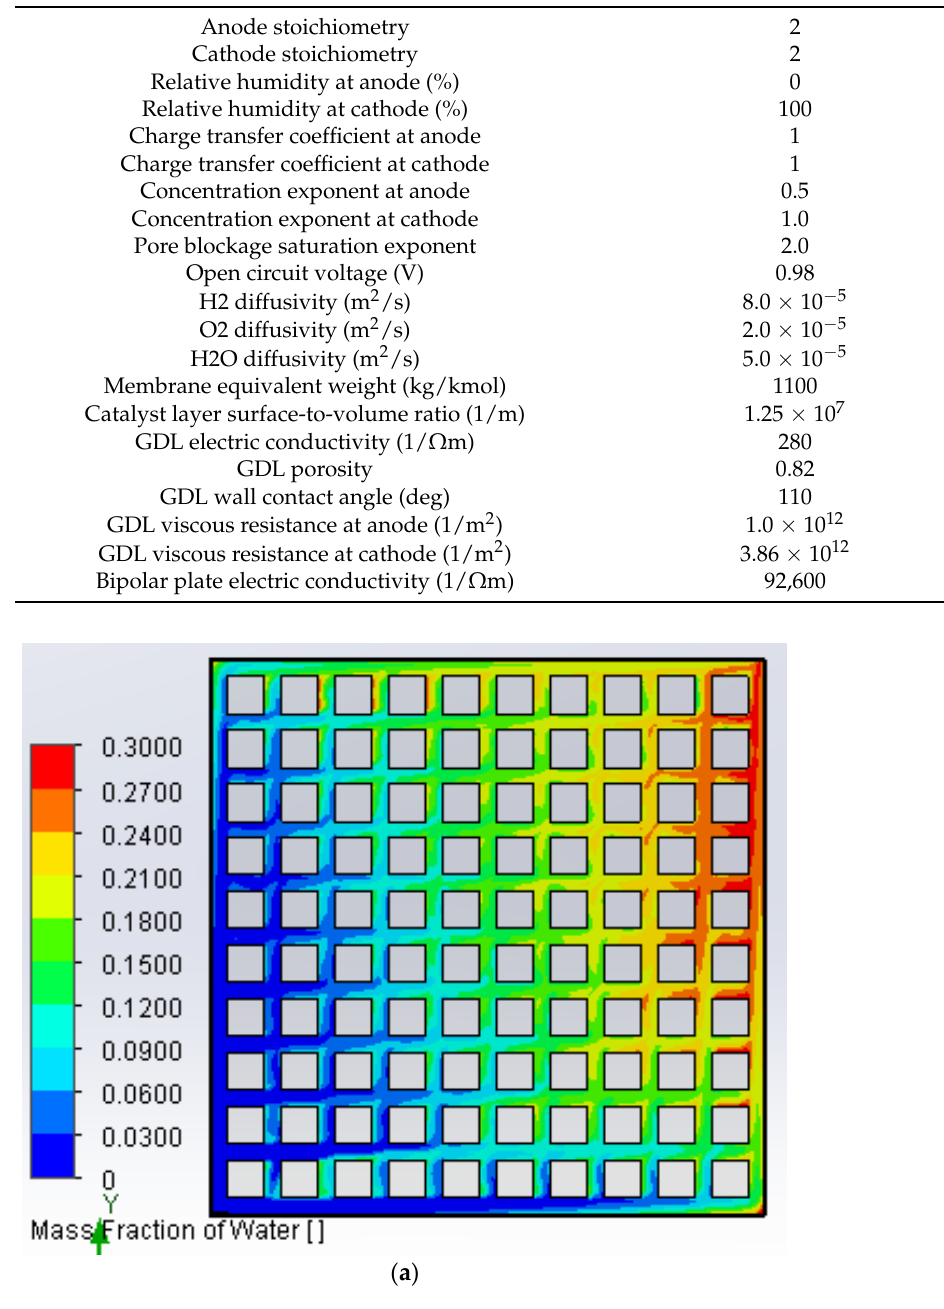
Table 5. Fuel cell CFD parameters.